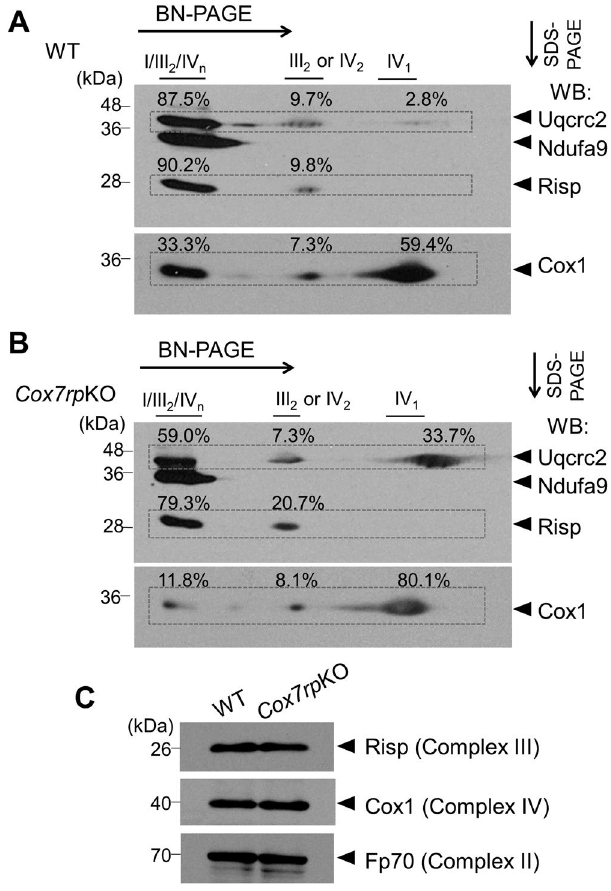
Figure 6. COX7RP promotes assembly of respiratory chain supercomplexes in hepatic mitochondria. Mitochondrial proteins of liver from WT ( A ) and Cox7rp KO ( B ) mice at 10-month-old were solubilized with digitonin in concentration of 8 g/g protein, and subjected to BN-PAGE followed by second-dimensional SDS- PAGE. Western blot analysis was performed with antibodies for Ndufa9 of complex I, Uqcrc2 of complex III, and Risp of complex III. The blots were stripped and reprobed with anti-Cox1 antibody. Positions corresponding to the supercomplexes I/III 2 /IV n and complexes III 2 or IV 2 are indicated. Percentages of Risp, Uqcrc2, Cox1 signal intensities involved in I/III 2 /IV n , III 2 or IV 2 , and IV 1 are shown on the images. ( C ) Mitochondrial proteins of liver from WT and Cox7rp KO mice at 10-month-old were subjected to SDS-PAGE. Western blot analysis was performed with antibodies for Risp, Cox1, and Fp70 of complex II. Unprocessed original scans of the blots are shown in Supplementary Fig. 2.